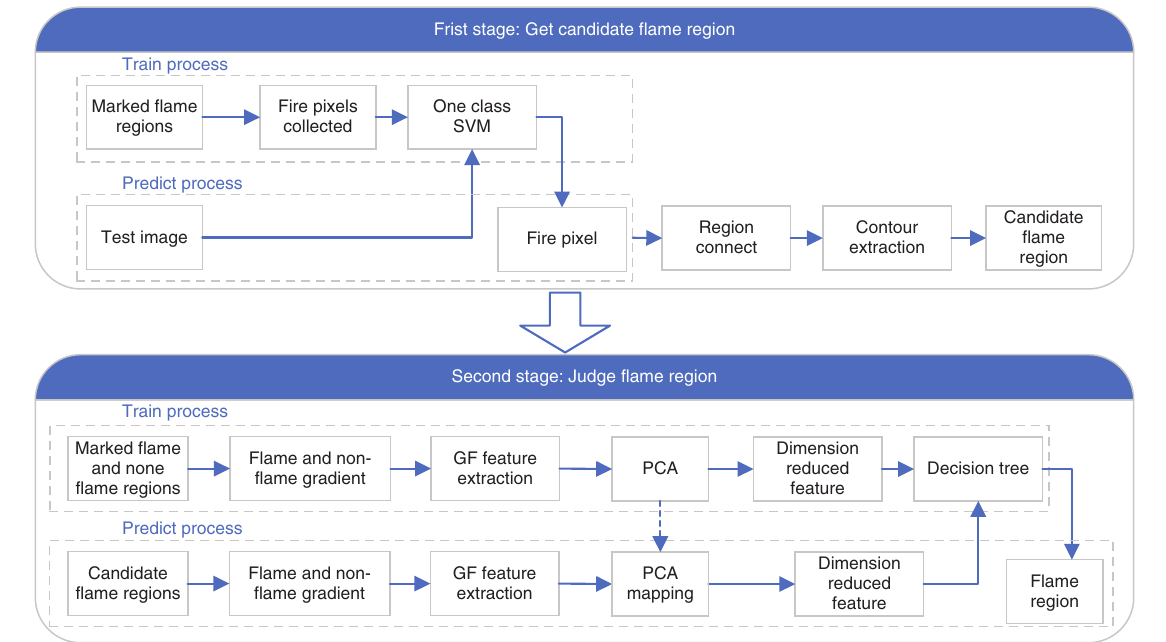
Figure 1: An Overview of the Structured Flame Detection Framework.